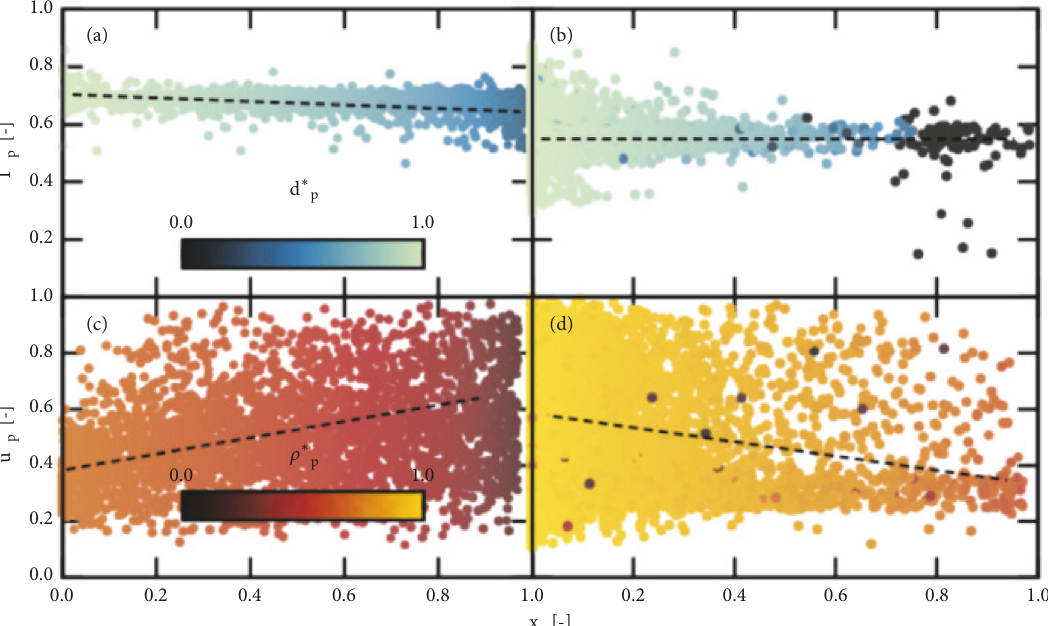
Figure 8: Normalised diameter, density, velocity magnitude ( 𝑢 ∗ 𝑝 = 𝑢 𝑝 /𝑢 𝑝,𝑚𝑎𝑥 ), and particle temperature ( 𝑇 ∗ 𝑝 = 𝑇 𝑝 / 𝑇𝑝,𝑚𝑎𝑥 ) variation during char conversion as a function of particle temperature: (a) and (c) SC, (b) and (d) SV. Particle ensemble collected after 6 seconds of physical runtime.